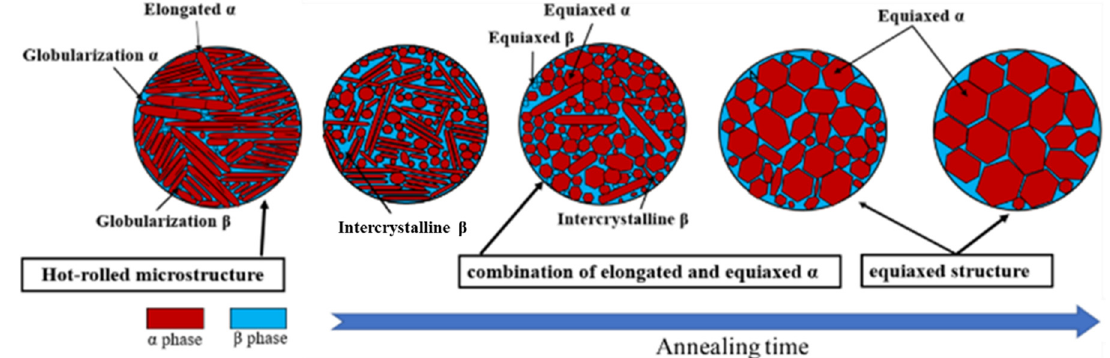
Figure 5. The surface scanning energy spectrum of TA10 alloy sheets annealed at 780 °C for 2 h ( a ) scanning surface, ( b ) Ti, ( c ) Mo, and ( d ) Ni.